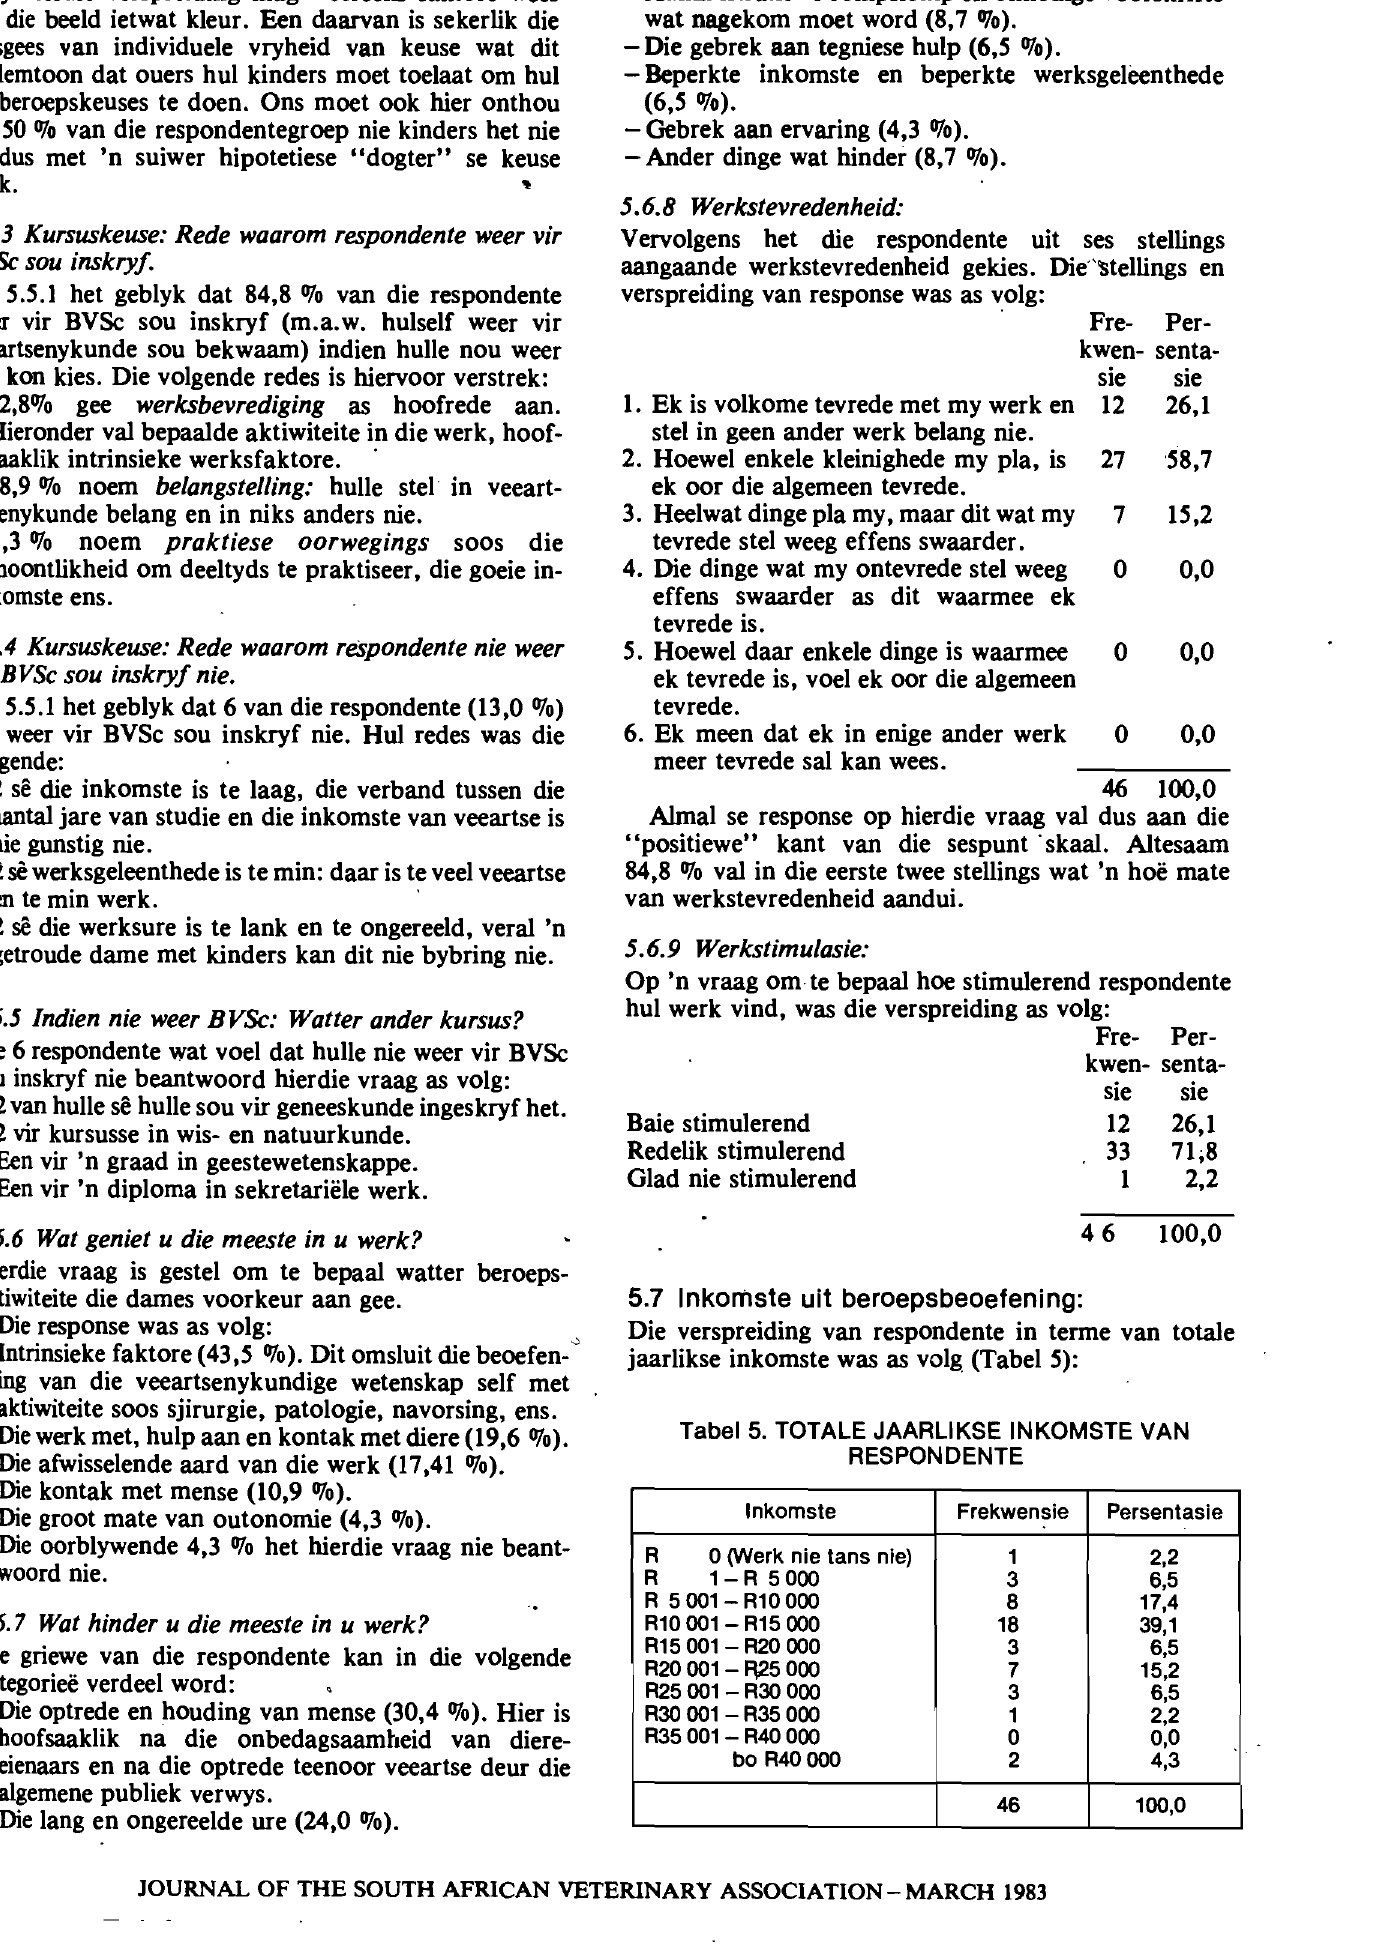
Tabel 5. TOTALE JAARLIKSE INKOMSTE VAN